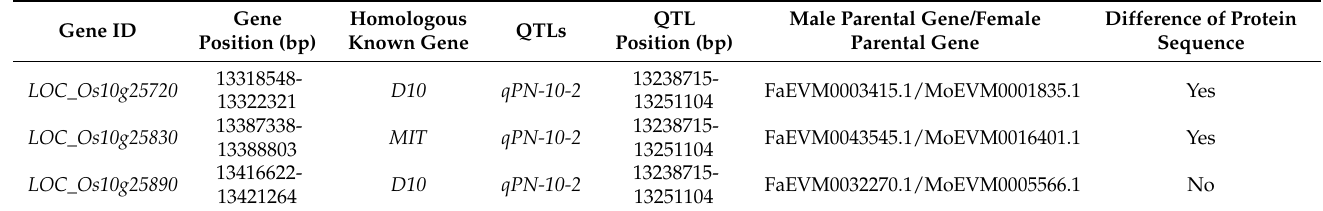
Table 1. Alignment results of parental protein sequences of three genes in qPN-10-2 .